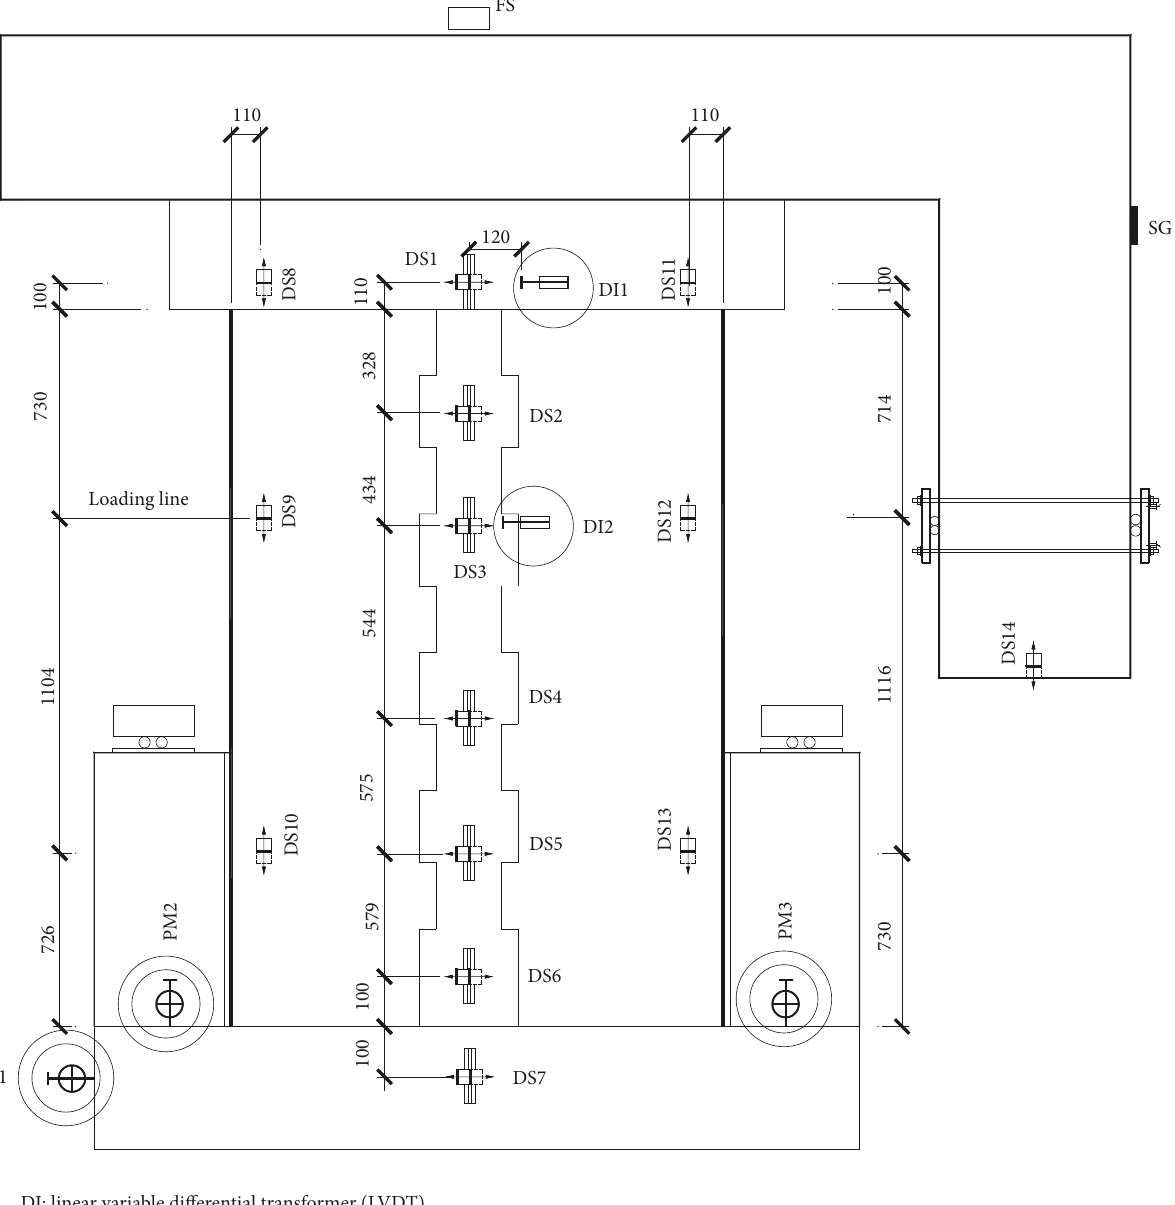
Figure 9: External